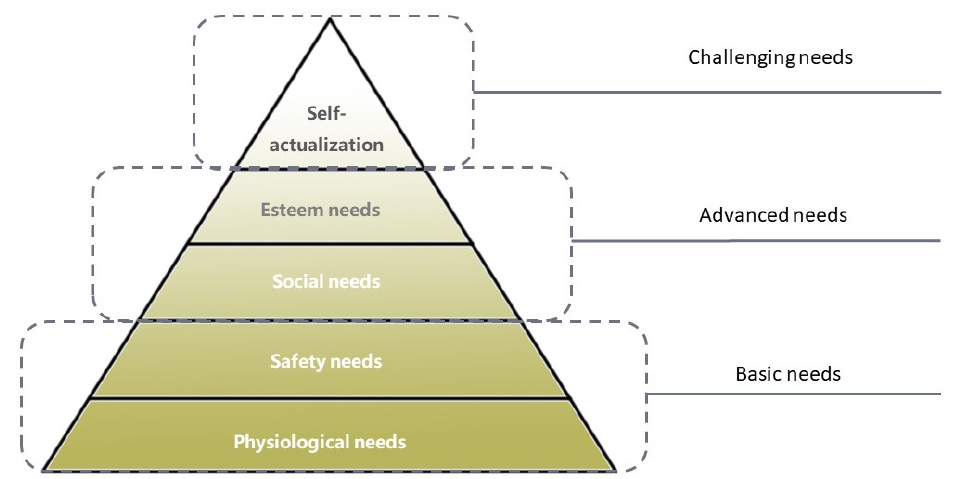
Figure 2. Maslow’s pyramid of human needs with further categorization (adapted by author, 2022).